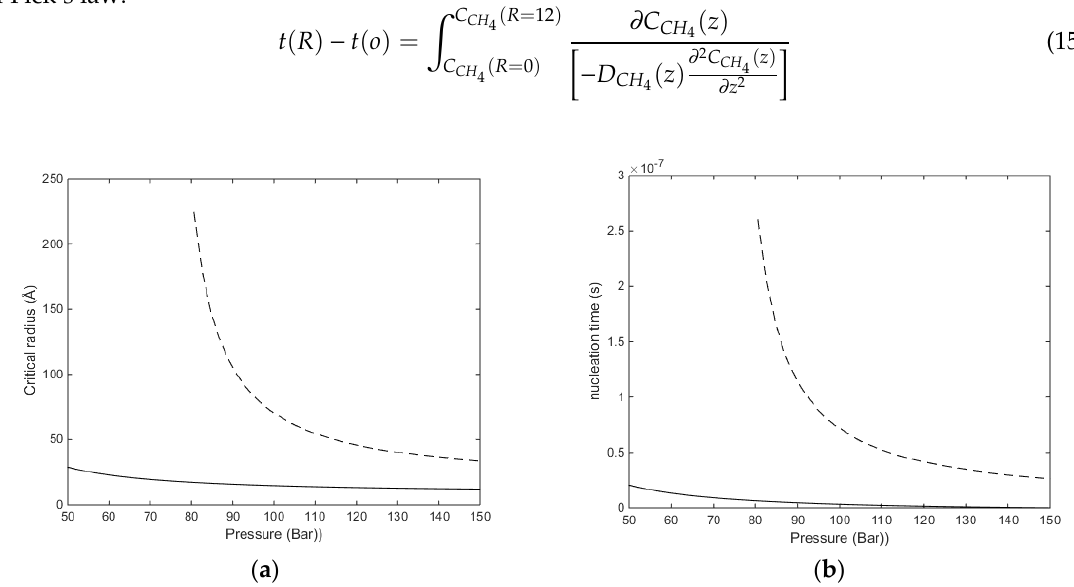
Figure 3. ( a ) Critical radius for CH 4 hydrate as function of pressure for two different temperatures. Solid curve is for 273.16 K and dashed curve is for 283.16 K. ( b ) Nucleation times for CH 4 hydrate as function of pressure for 273.16 K (solid) and 283.16 K (dashed).